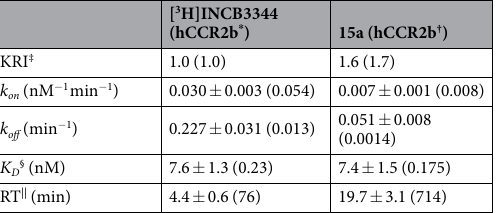
Table 1. Kinetic characterization of [ 3 H]INCB3344 and 15a in membranes of CHO cells transiently expressing murine CCR2 (mCCR2). Values are means ± S.E.M of three separate experiments performed in duplicate. * Values of [ 3 H]INCB3344 for hCCR2b were taken from Vilums et al. 25 . † Values of 15a for hCCR2b were taken